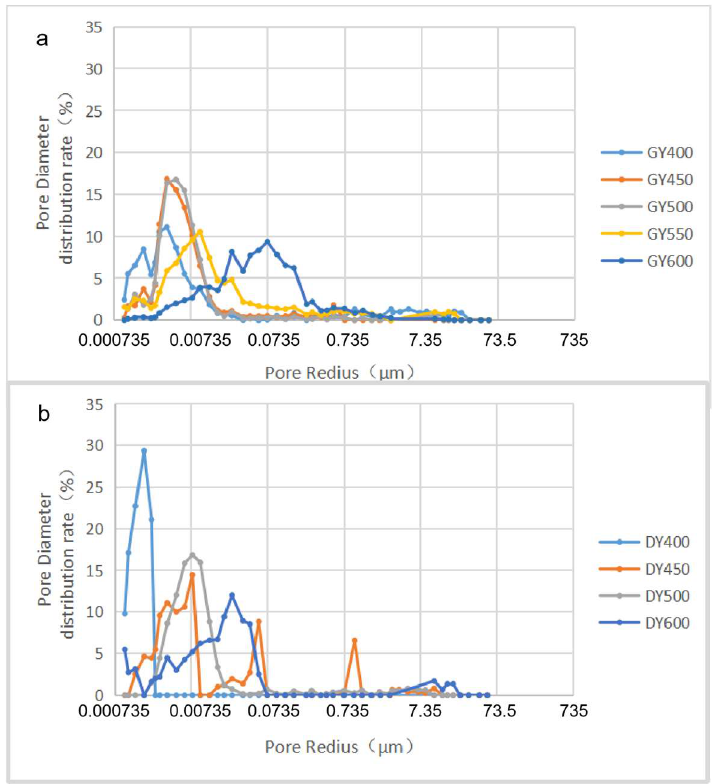
Figure 9. Pore size distribution derived from the mercury intrusion experiment. ( a ) Semiclosed and ( b ) open systems.